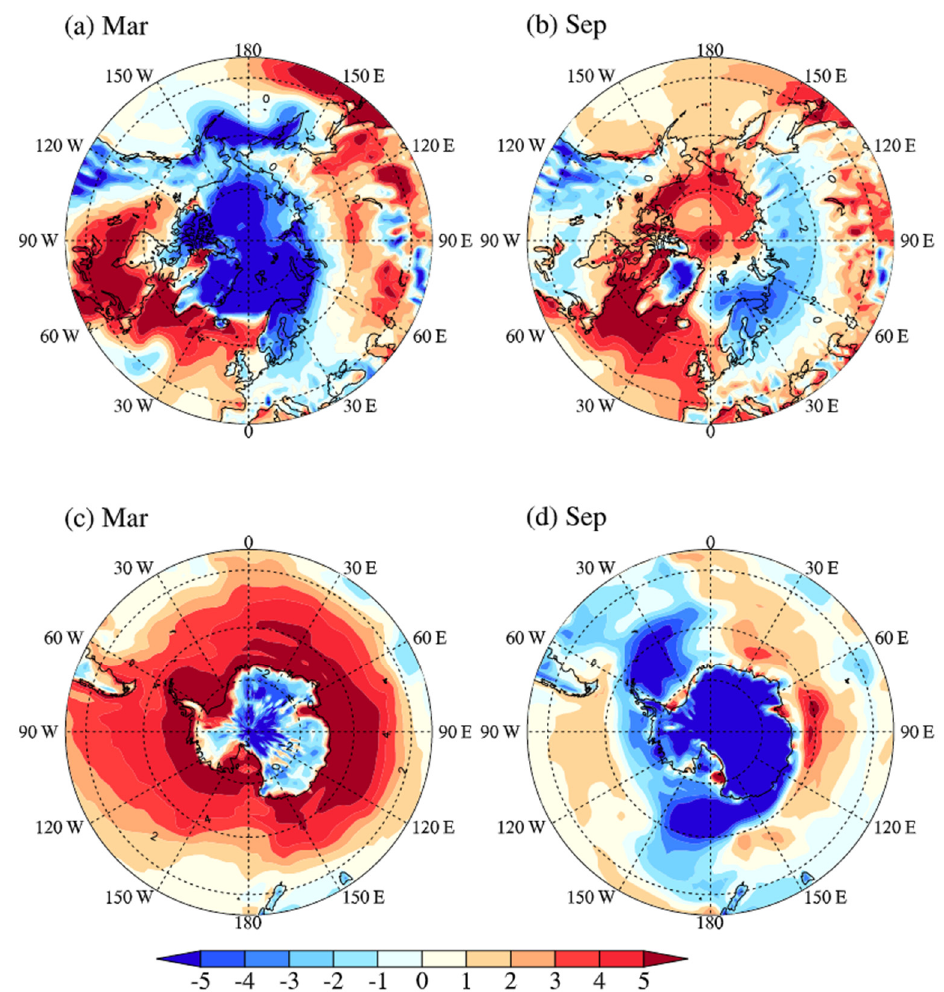
Figure 7. Spatial patterns of SAT bias relative to NCEP data [35] in ( a , c ) March and ( b , d ) September in the Arctic (upper panel) and Antarctic (lower panel).